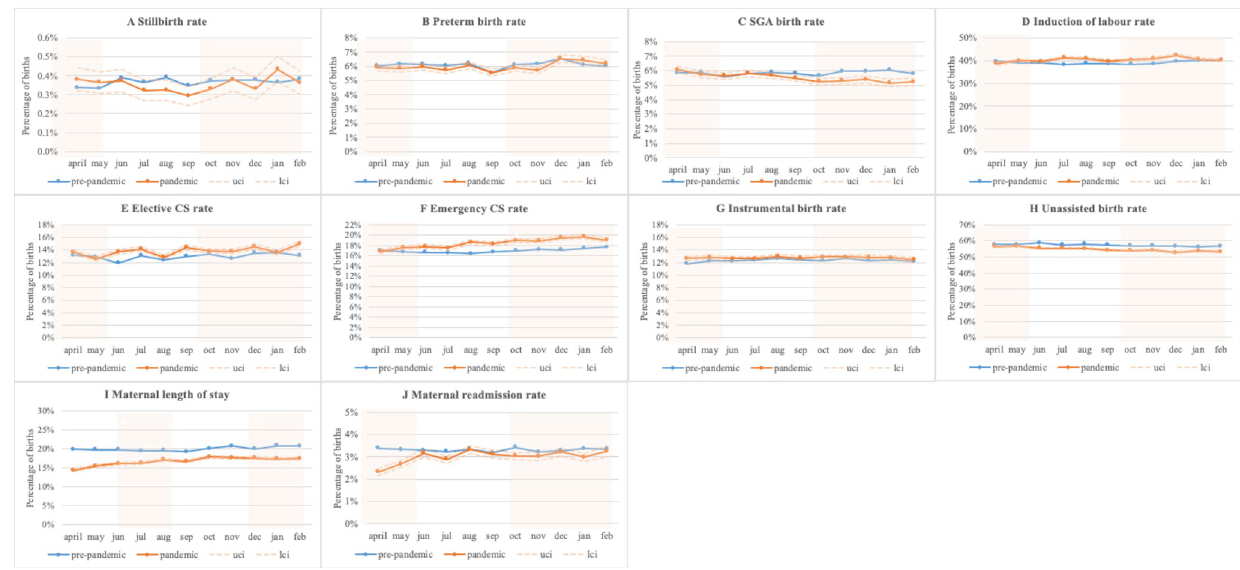
Fig 1. Study outcome rates by month in the pre-pandemic (April 2019–February 2020) and pandemic (April 2020–February 2021) periods. (A) Stillbirth; (B) preterm birth; (C) small for gestational age (SGA); (D) induction of labour; (E) elective cesarean section (CS); (F) emergency CS; (G) instrumental birth; (H) unassisted birth; (I) prolonged maternal le ngth of stay; (J) maternal readmission. lci, 95% lower confidence interval; uci, 95% upper confidence interval.